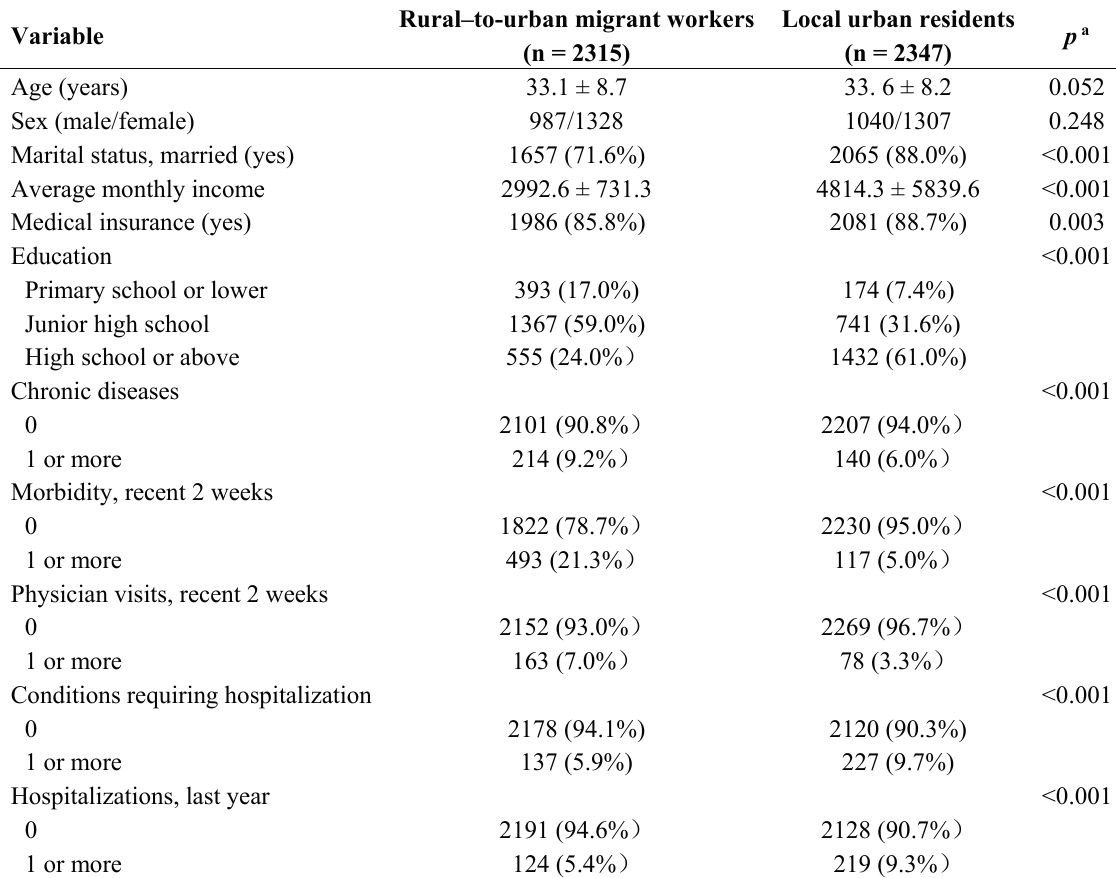
Table 1. Characteristics of rural-to-urban migrant workers and local urban residents in the study population, Shenzhen-Dongguan economic zone,